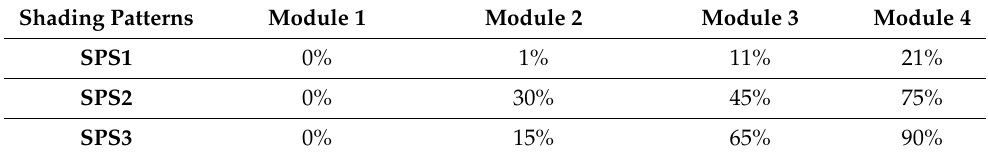
Table 1. Percentage insolation reduction on the four PV modules taking as a reference full insolation. Shading Patterns Module 1 Module 2 Module